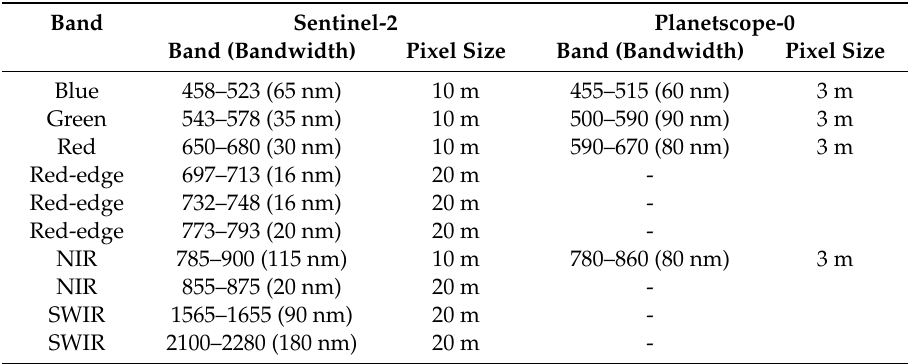
Table 1. Sentinel-2 [1] and Planetscope-0 [3] spectral bands used in this